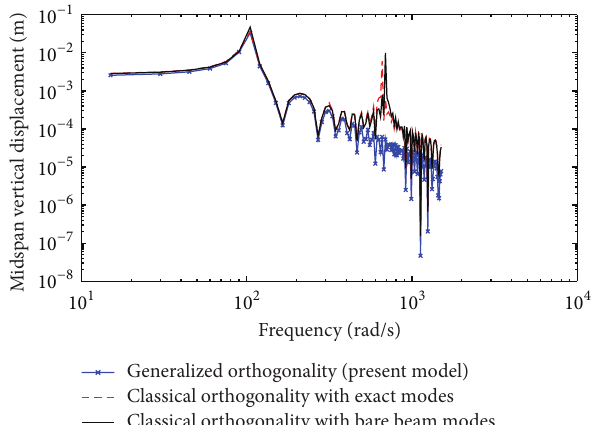
Figure 5: Frequency response of a simply supported beam carrying one in-span mass-spring-damper-mass system for 𝑘 = 10 N/m, = 0.1 kg, 𝑀 = 0.05 kg, 𝑇 = 360 N, 𝐸𝐼 = 36.458 Nm 2 , 𝑐 𝑀 𝑑 𝑐 = 0.1 m. 0.1 Ns/m, and 𝐿 𝑑